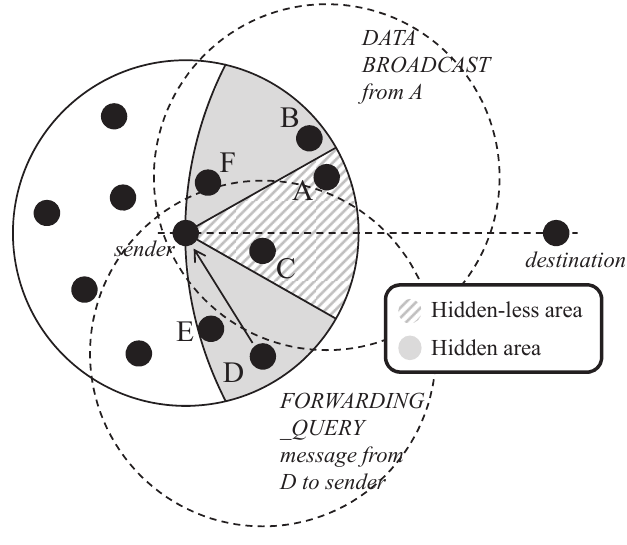
Figure 2. Data forwarding in the proposed